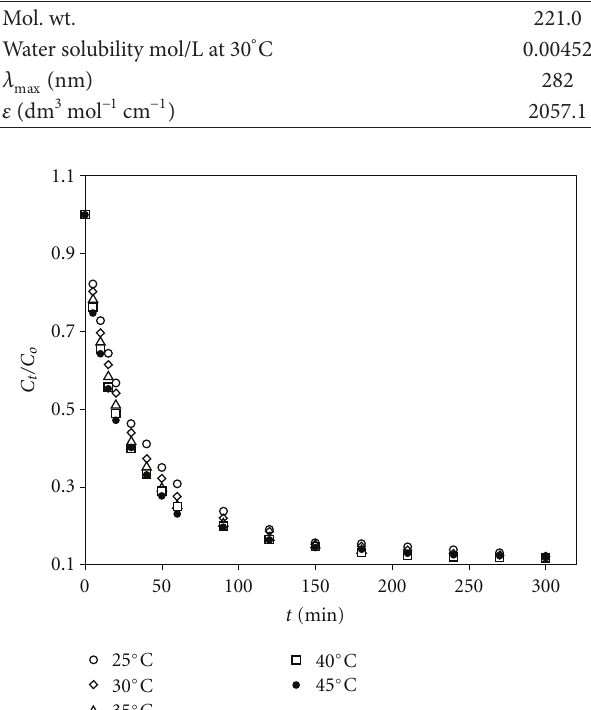
type of isotherm.